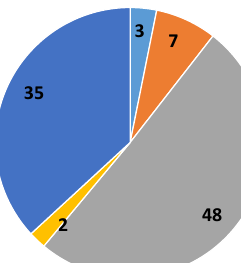
Figure 2. Designation of participants.